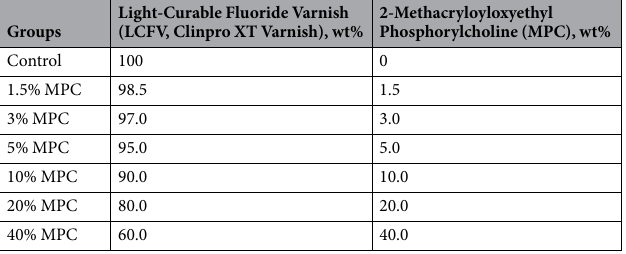
Table 1. Compositions of the tested